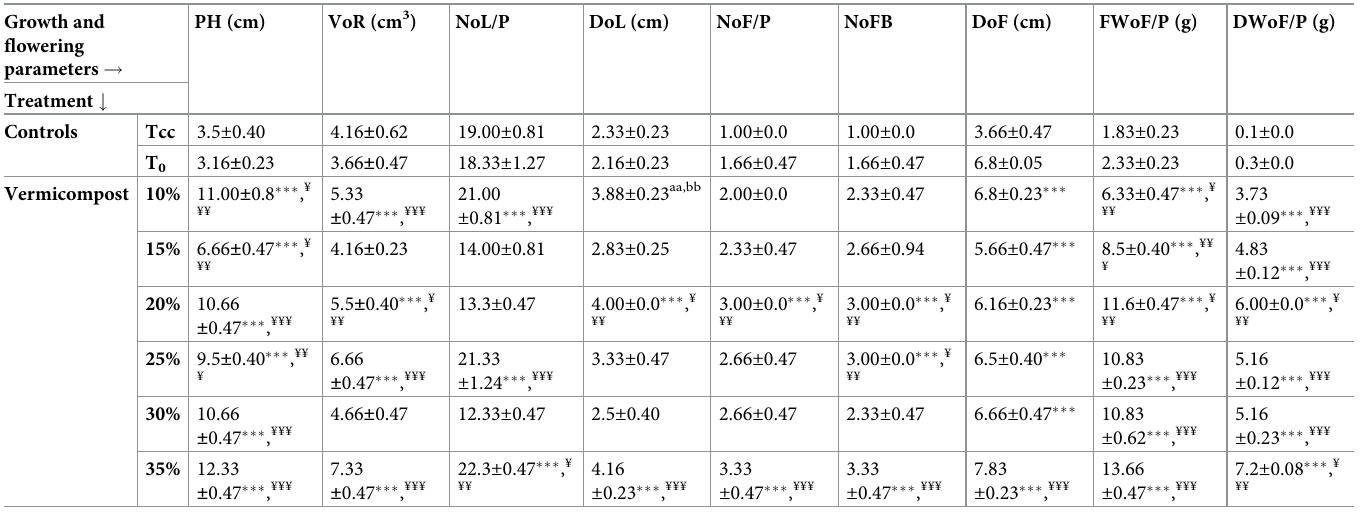
Table 5. Effect of germination media on vegetative plant growth and flowering parameters of pansy. Growth and